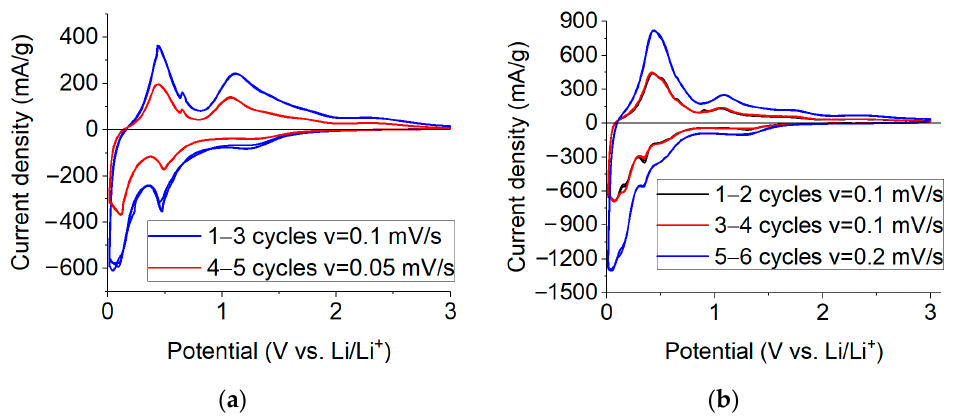
Figure 3. ( a ) CVs for CoGe 2 P 0.1 at two scan rates; ( b ) CVs of the lithium insertion/extraction into/from Ge-Co nanostructure .